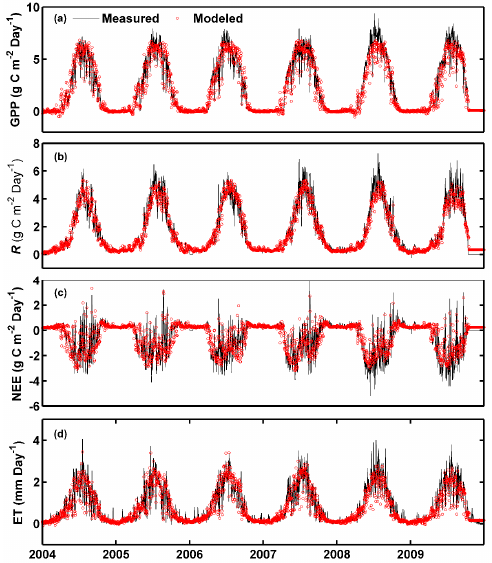
Figure 3. Eddy covariance-measured and ANN model-simulated daily carbon and water fluxes in the whole period from 2004 to 2009. ( a ) GPP; ( b ) R ; ( c ) NEE; and ( d ) ET.